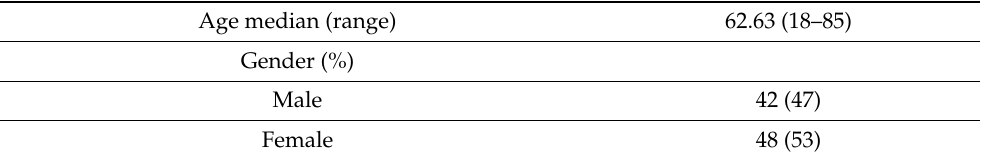
Table 1. Clinical-laboratory characteristics of patients with